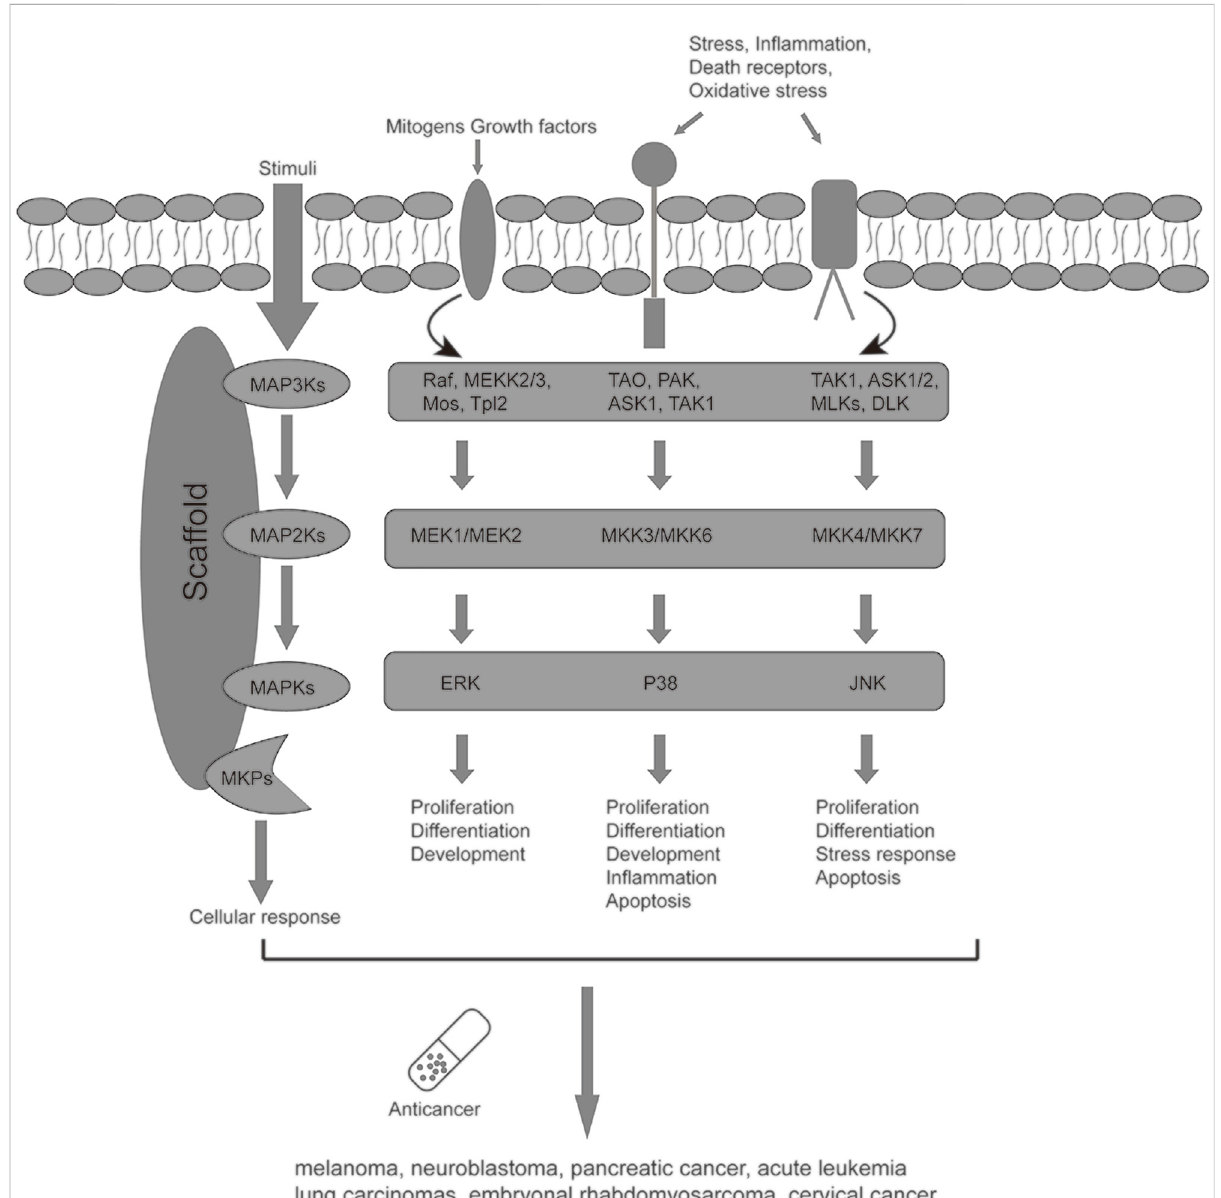
FIGURE 1 The known MAPK signaling pathways downstream target cell receptor signaling, working cooperatively to regulate cell physiology.